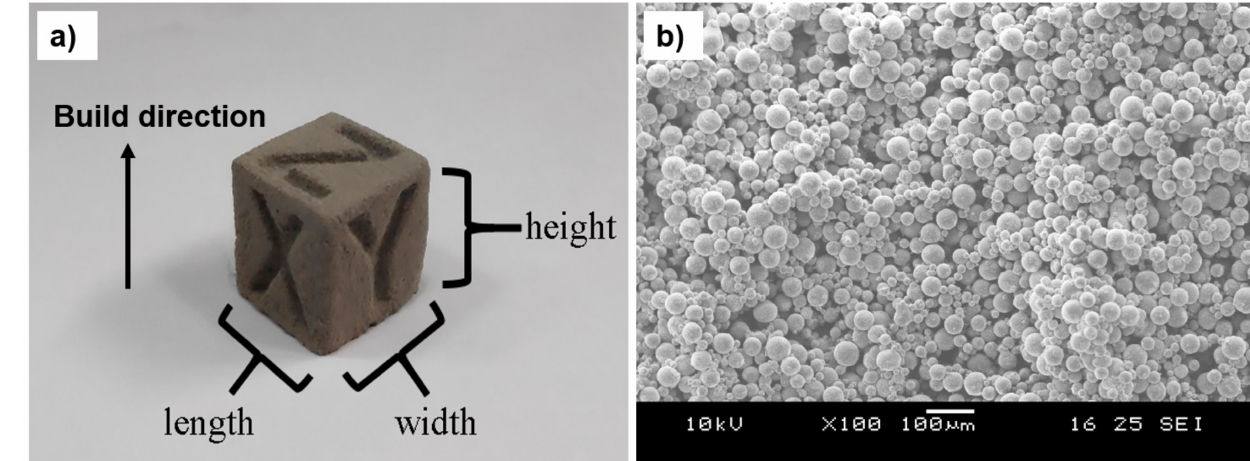
Figure 3. As-printed green AZ91D powder additively manufactured via capillary-mediated binder- less printing with an SL of 70%. ( a ) A macrograph of a cube with imprints and ( b ) an SEM image showing the formation of solid interparticle bridges from the interaction between ink and powder.